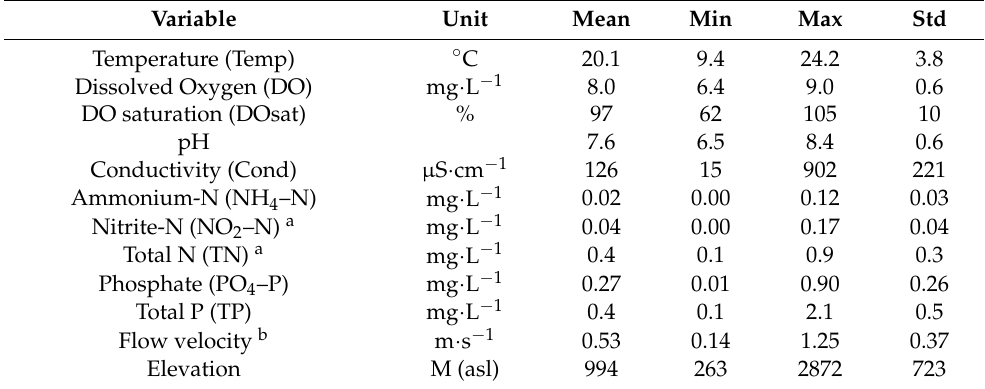
Table 1. Mean, minimum (Min), maximum (Max), and standard deviation (Std) of continuous variables measured in 15 sampling sites (asl = above sea